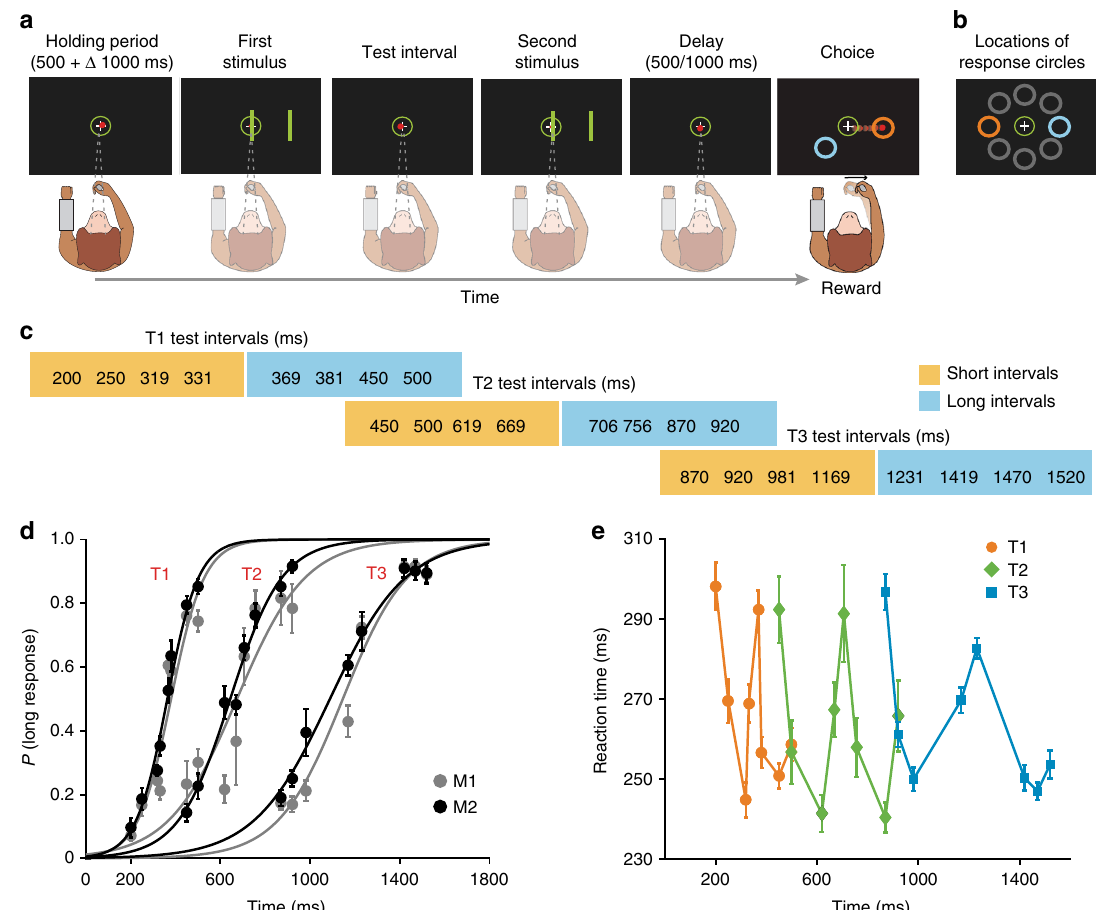
Fig. 1 Trial events during the interval categorization task and behavioral results. a Monkeys categorized the interval between the fi rst and second stimulus presentation as “ short ” or “ long ” by moving the red cursor into the orange or blue circular targets, respectively. b An example of a possible target con fi guration, with the response circles 180° apart. Gray circles (not visible in the actual task) show the eight possible target locations. c The three blocks of stimuli employed in this study (T1, T2, and T3). The short/long implicit limits for T1, T2, and T3 are 350, 685, and 1195 ms, respectively. Note that some time durations could be correctly categorized either as “ short ” or as “ long ” depending on the particular block presented to the monkey. d Psychometric curves for the two monkeys for the three blocks of durations. Dots represent the mean (±SEM) probability of categorizing a particular interval as long. e Mean (±SEM) of the reaction times of the monkey 1 as a function of the test intervals for the three blocks of